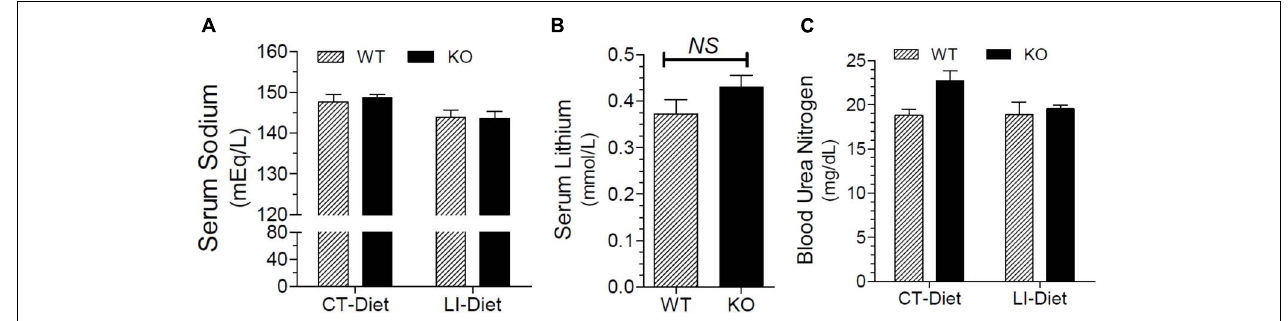
FIGURE 9 | Representative profiles of morphological appearance of kidneys of WT and P2Y 2 KO mice fed control (CT) or lithium-added (LI) diets for 5 months. Formalin-fixed and paraffin-embedded kidney samples were sectioned and stained with hematoxylin-eosin. (A–C) WT control mice; (D–F) WT lithium mice; (G–I) KO control mice; and (J–L) KO lithium mice. CM Junction – cortico medullary junction. Bar represents 50 µ m.